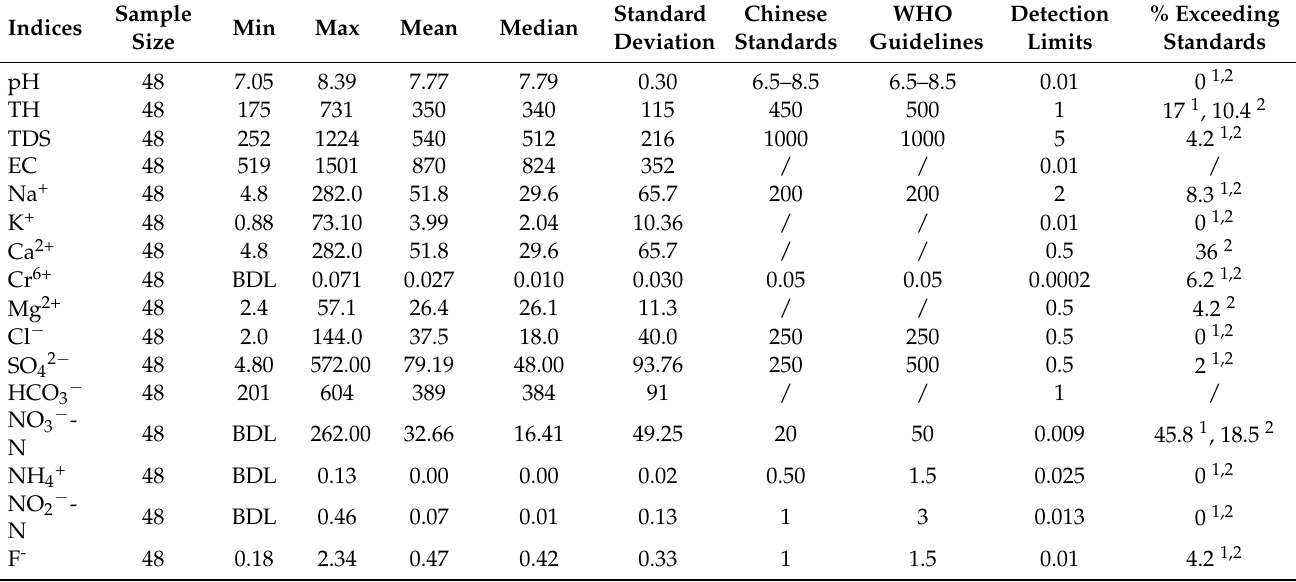
Table 1. Statistical analysis of physicochemical indices for water samples collected in